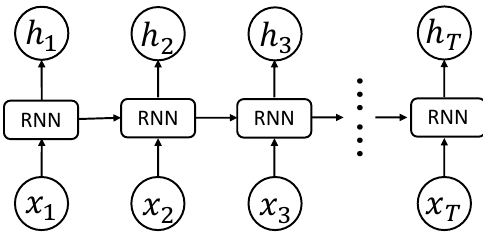
Figure 1. The structure of